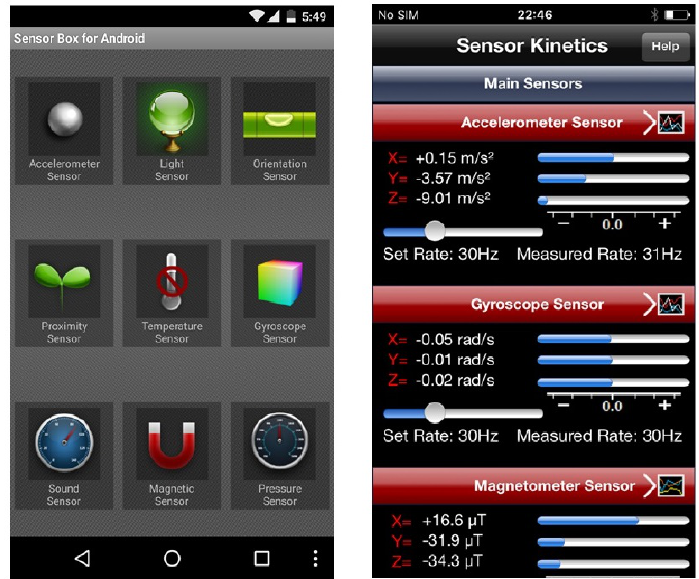
Figure 2. Android ( left ) and iOS ( right ) sensor apps used in the